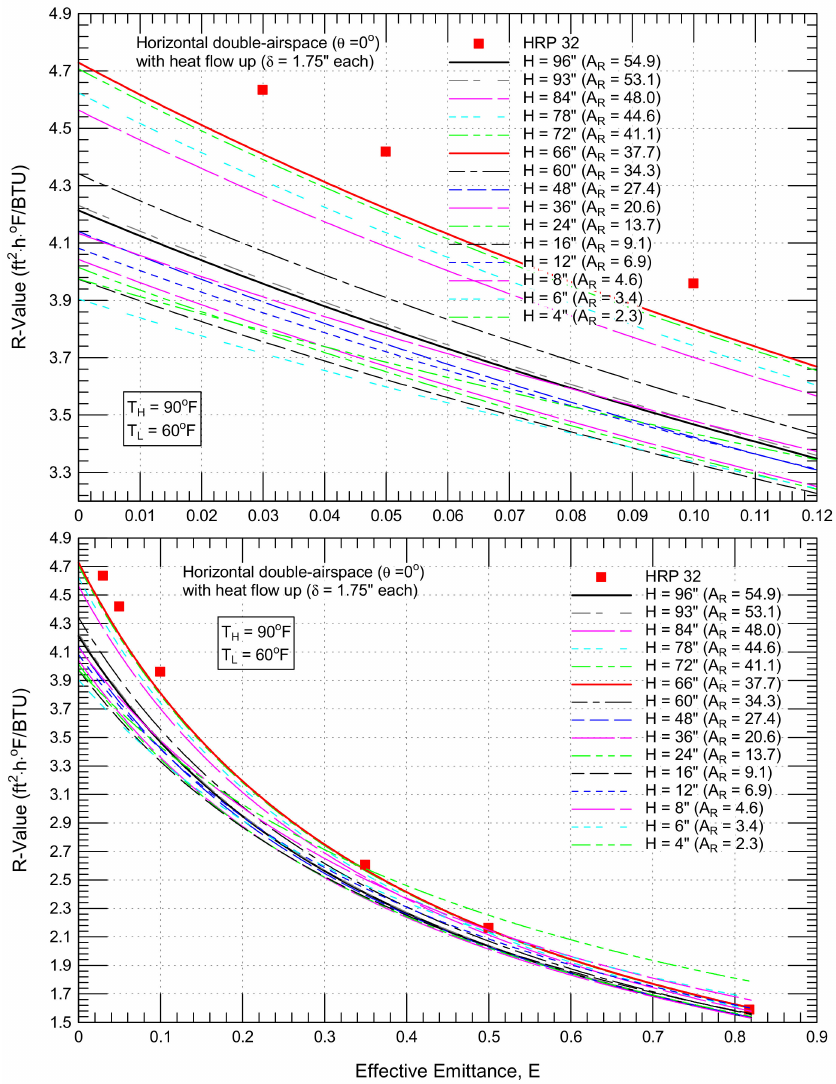
Figure 15. Comparisons of R values of HRP 32 [4] with present model predictions of various A R for double airspaces subjected to an upward heat flow ( θ = 0 ◦ , total δ = 3.5 inches, T H = 90 ◦ F, T L = 60 ◦